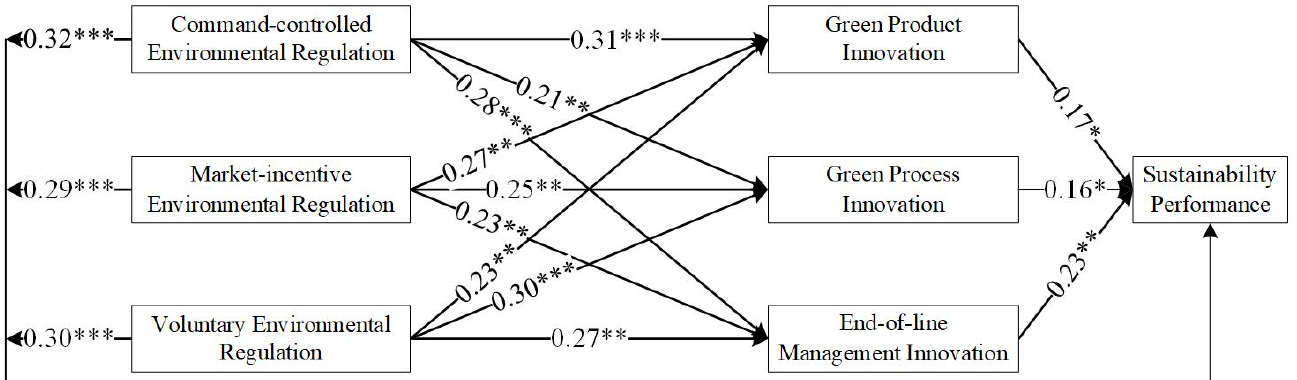
Figure 2. Results of the hypothesized model in China. * denotes p < 0.05; ** denotes p < 0.01; *** denotes p < 0.001.